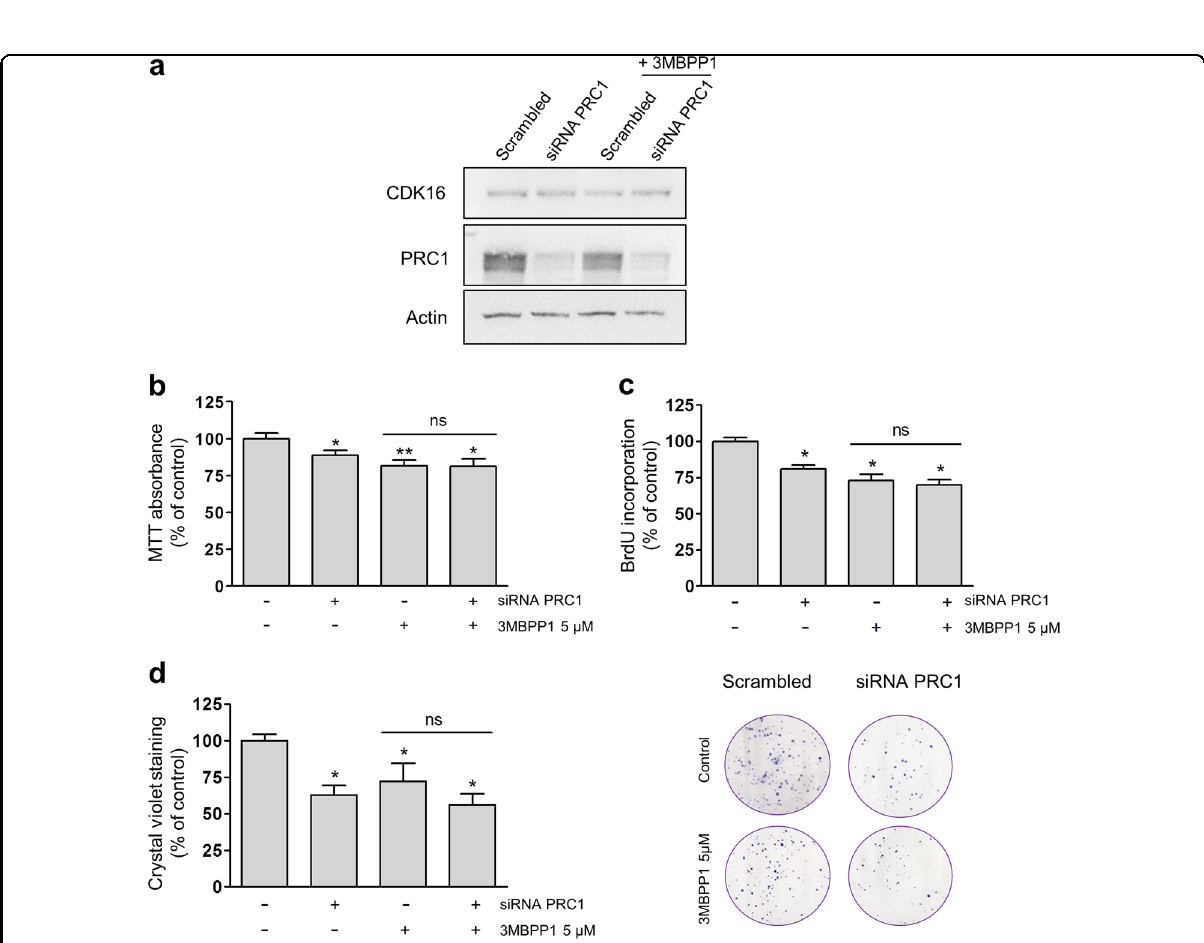
Fig. 6 The proliferative action of CDK16 is mediated by PRC1 phosphorylation. a – c Here, 293T AS-CDK16 cells were seeded and transfected the following day with siRNA targeting PRC1 or with scrambled control and treated with 0 or 5 µM 3MBPP1. a Western blot analysis was performed to con fi rm PRC1 downregulation. b Cell viability was monitored by an MTT assay, and the columns represent the means ± SEMs of 6 independent experiments performed in triplicate. * P < 0.05, ** P < 0.01 vs control; Mann – Whitney test. c Cell proliferation was assessed by a BrdU incorporation assay 72 h after transfection. The columns represent the means ± SEMs of 4 independent experiments performed in triplicate. * P < 0.05 vs control, Mann – Whitney test. d Here, 293T AS-CDK16 cells were seeded and transfected the following day with siRNA targeting PRC1 or with scrambled control siRNA. After 3 days, the cells were detached, seeded in 6-well plates and treated with 0 or 5 µM 3MBPP1. The colony formation ability was assessed 2 weeks later. The columns represent the means ± SEMs of 4 independent experiments performed in duplicate. * P < 0.05 vs control, Mann – Whitney test